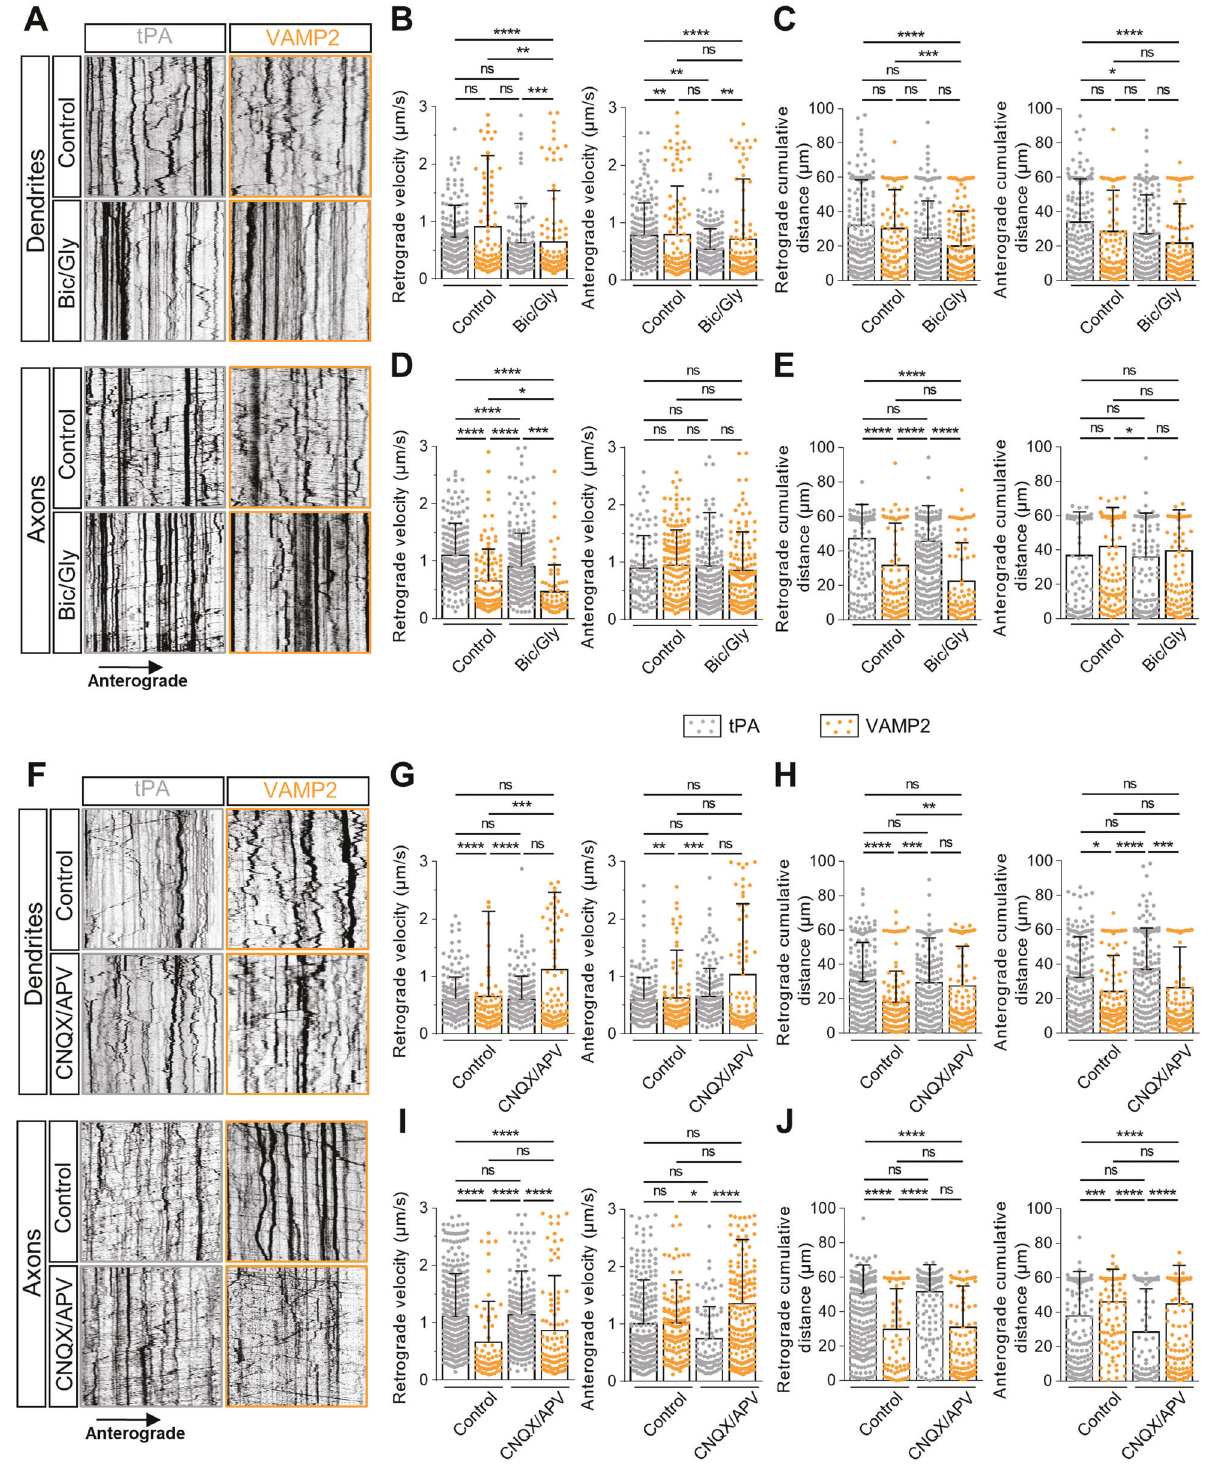
The axonal anterograde V-tPA show similarities with VAMP2 positive vesicles in resting and activating state of neurons suggesting a co-traf fi cking in the same vesicles (Figs. 5, S4). tPA has been identi fi ed in dense core vesicles (DCVs) [42] and in a subset of DCVs-containing VAMP2 [26, 43]. We found that tPA and v-SNARE VAMP2 had the same axonal anterograde vesicle velocity and the same vesicle distance traveled in control and in activating